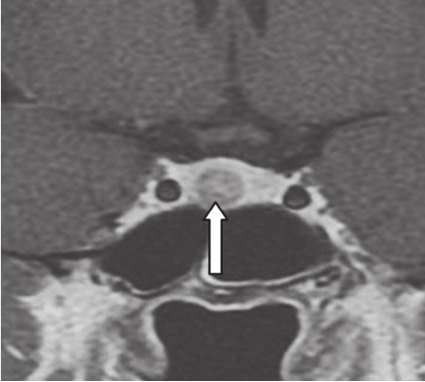
Figure 4: MRI of the pituitary